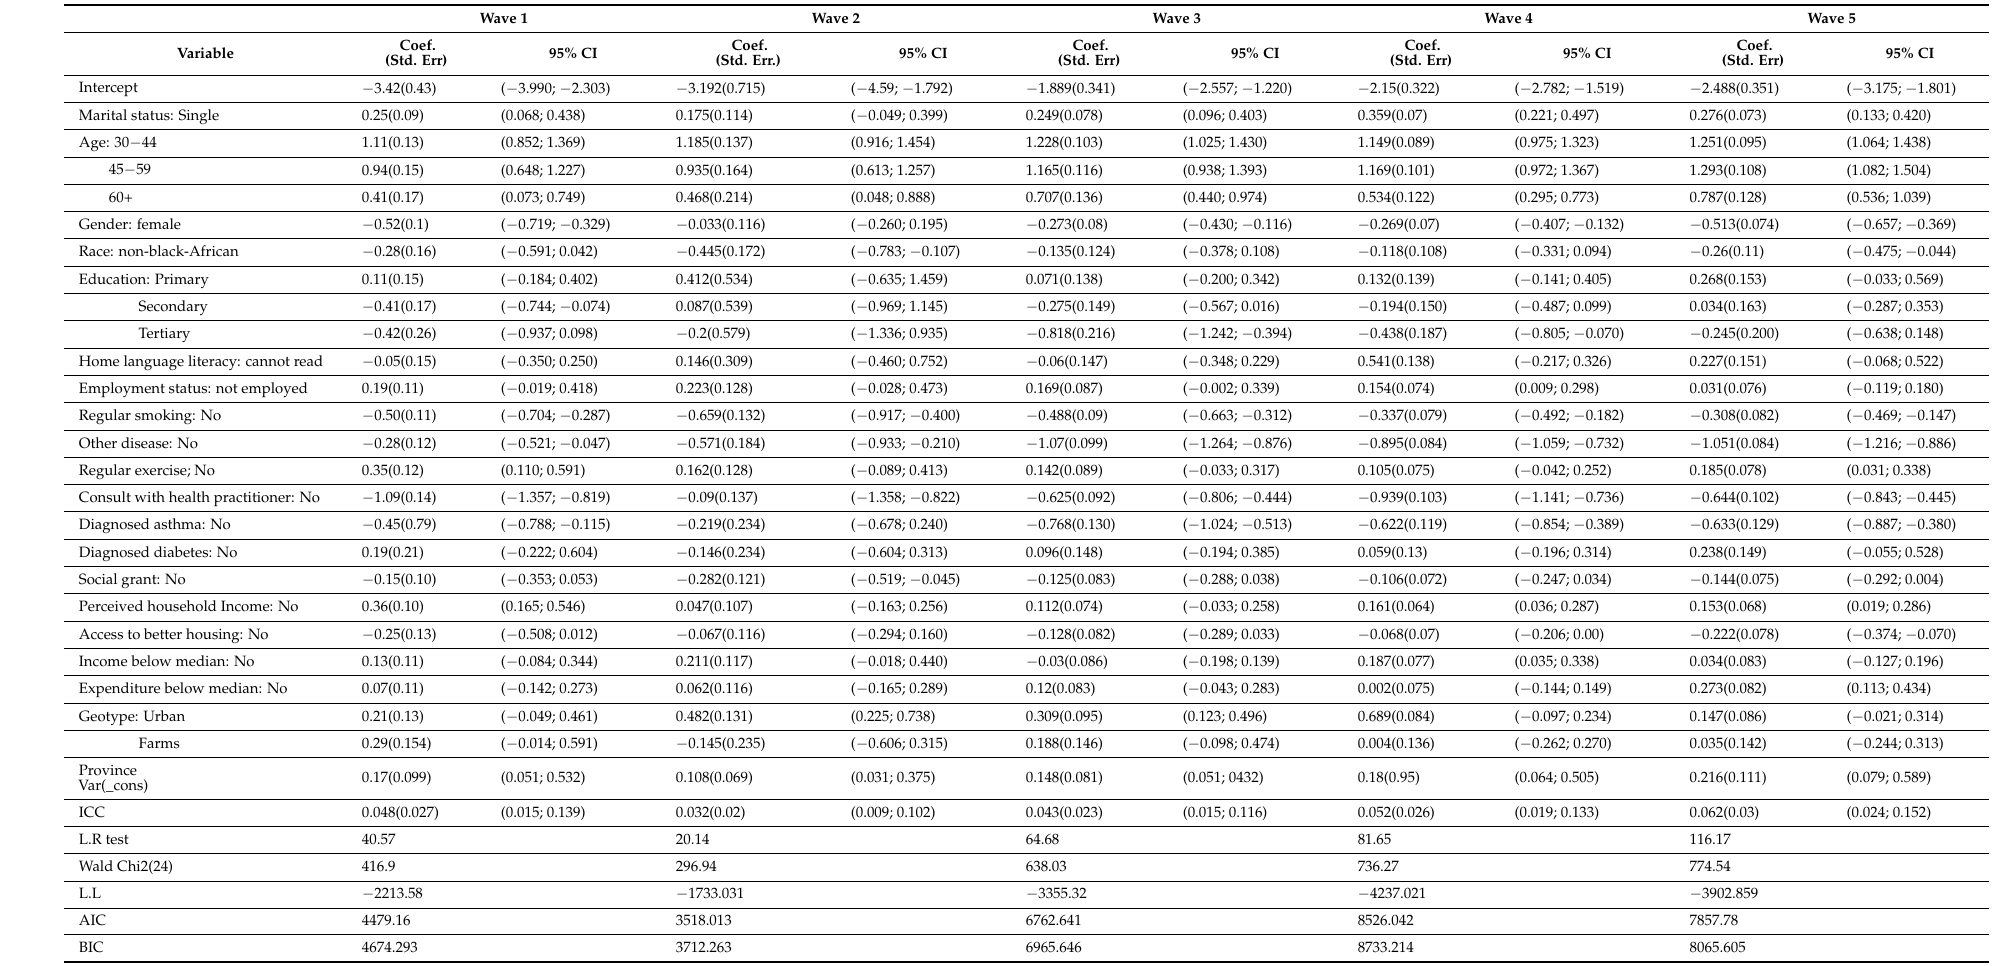
Table A1. Waves 1 to 5 Frequentist